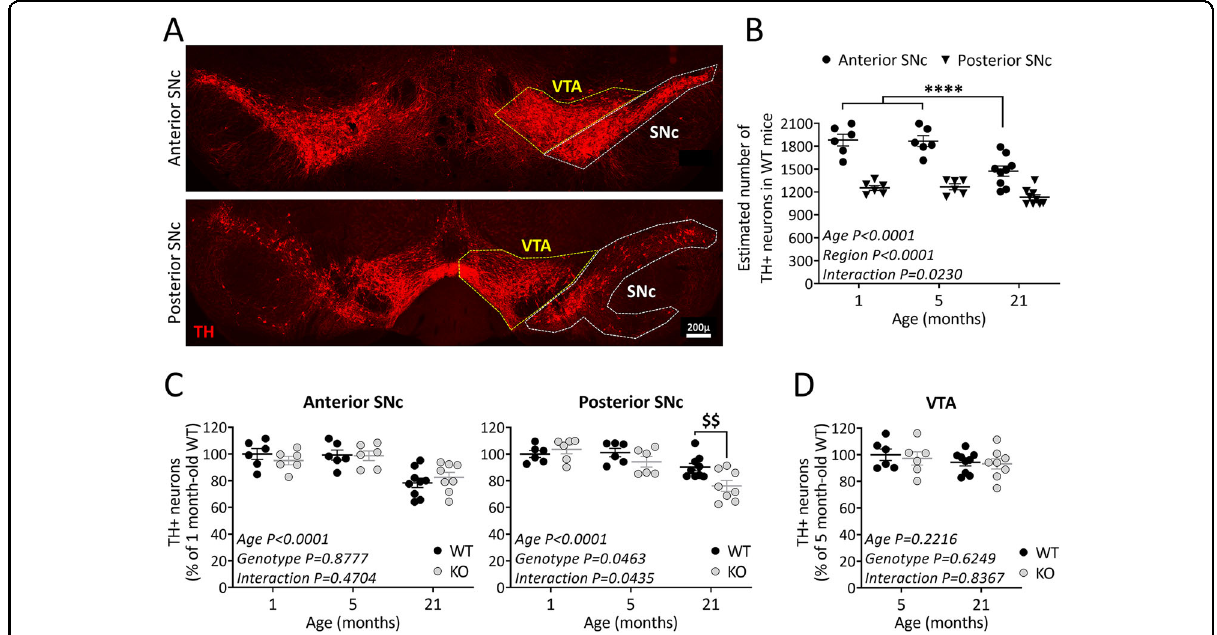
Fig. 1 TP53INP1 de fi ciency impacts the intranigral pattern of ageing-related loss of TH-positive neurons. A Representative image of TH immunolabeling in the midbrain. VTA and SNc were delineated for quanti fi cation. SNc was subdivided into anterior and posterior parts. Scale bar 200 µm. B Effect of ageing on the numbers of TH-positive neurons in the two SNc subdivisions. Estimated total numbers of neurons were compared between 1, 5, and 21 month-old WT mice. Age-related loss of TH + neurons is restricted to the anterior SNc, which shows higher numbers of these neurons than the posterior part in 1 and 5 month-old mice. **** P < 0.0001 21 versus 1 or 5 month-old mice. C Effect of TP53INP1 de fi ciency on the age-related evolution of TH + neuron numbers in the anterior and posterior SNc. Counts were performed in WT and Trp53inp1 − / − (KO) mice and expressed as % of 1 month-old WT mice. 21 month-old Trp53inp1 − / − mice show loss of TH + neurons in the anterior SNc equivalent to WT and an additional loss in the posterior SNc. $$ P = 0.0075 KO versus WT. D Effects of ageing and of TP53INP1 de fi ciency on the numbers of TH + neurons in the VTA. No signi fi cant changes are measured in either condition. In graphs, data are expressed as means ± SEM of n mice per group (1 month-old: 6 WT and 6 KO, 5 month-old: 6 WT and 6 KO, 21 month-old: 9 WT and 8 KO), and results of the two-way ANOVA are indicated. Only signi fi cant interaction is